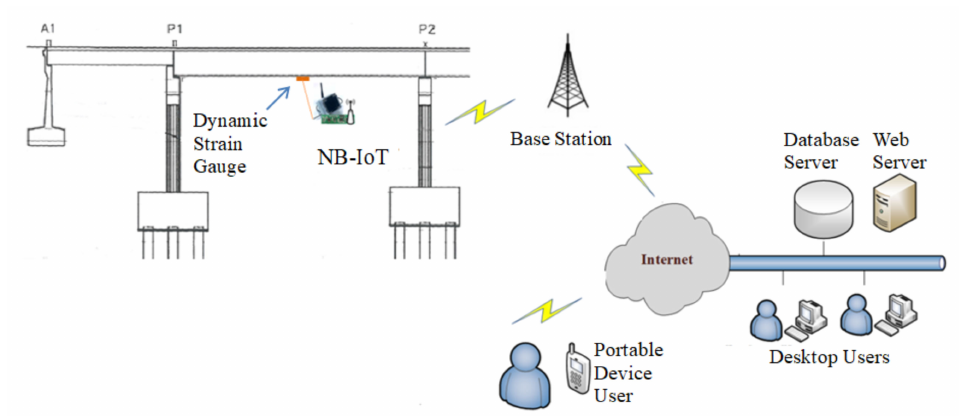
Figure 12. Schematic of the monitoring architecture of the wireless dynamic strain gauge based on NB-IoT that was used in this